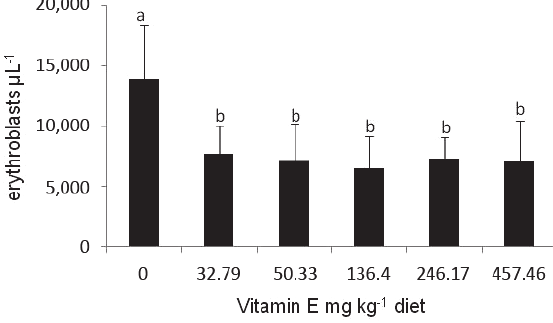
Fig. 1 – Erythroblast number (μ ± SD) of juvenile pacu P. mesopotamicus fed increasing levels of dietary vitamin E. Different letters above columns indicate differences by Tukey test